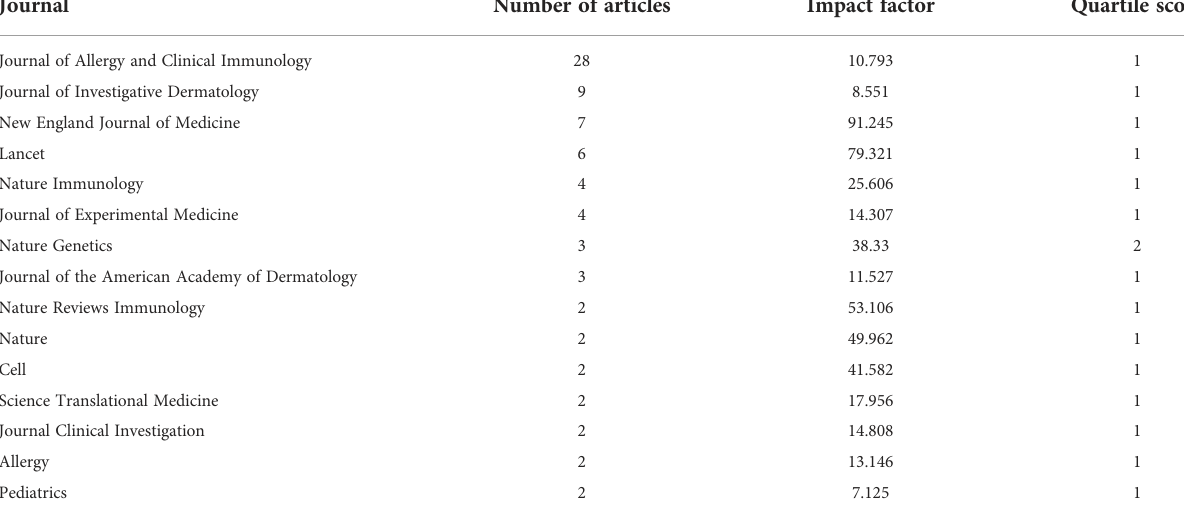
TABLE 2 Top 10 list of journals with published articles.